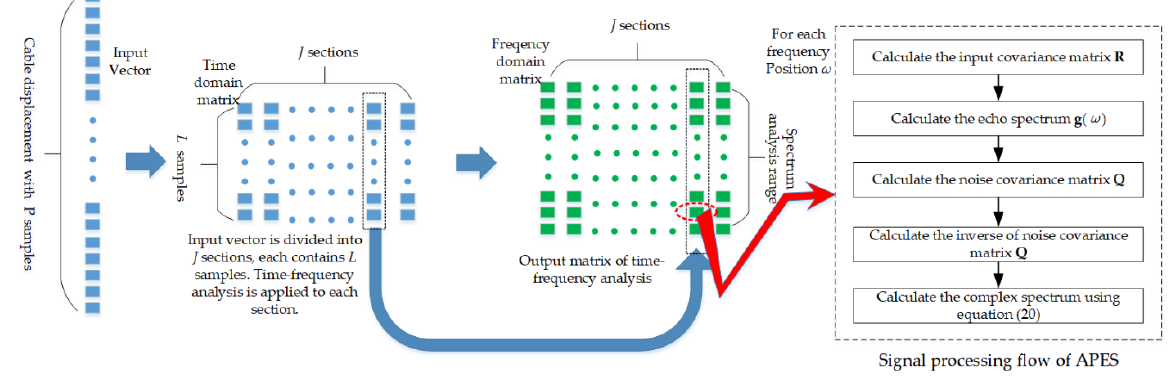
Figure 1. Time-frequency analysis flow charts of a bridge